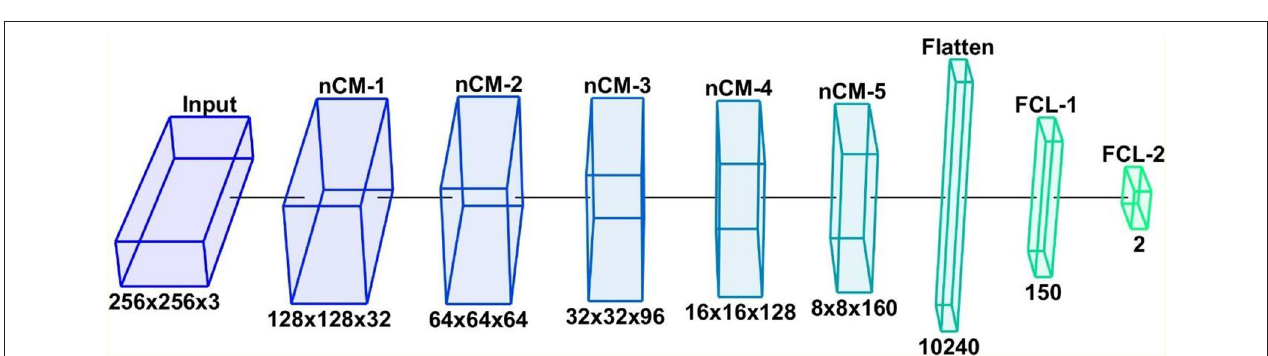
Frontiers in Public Health |